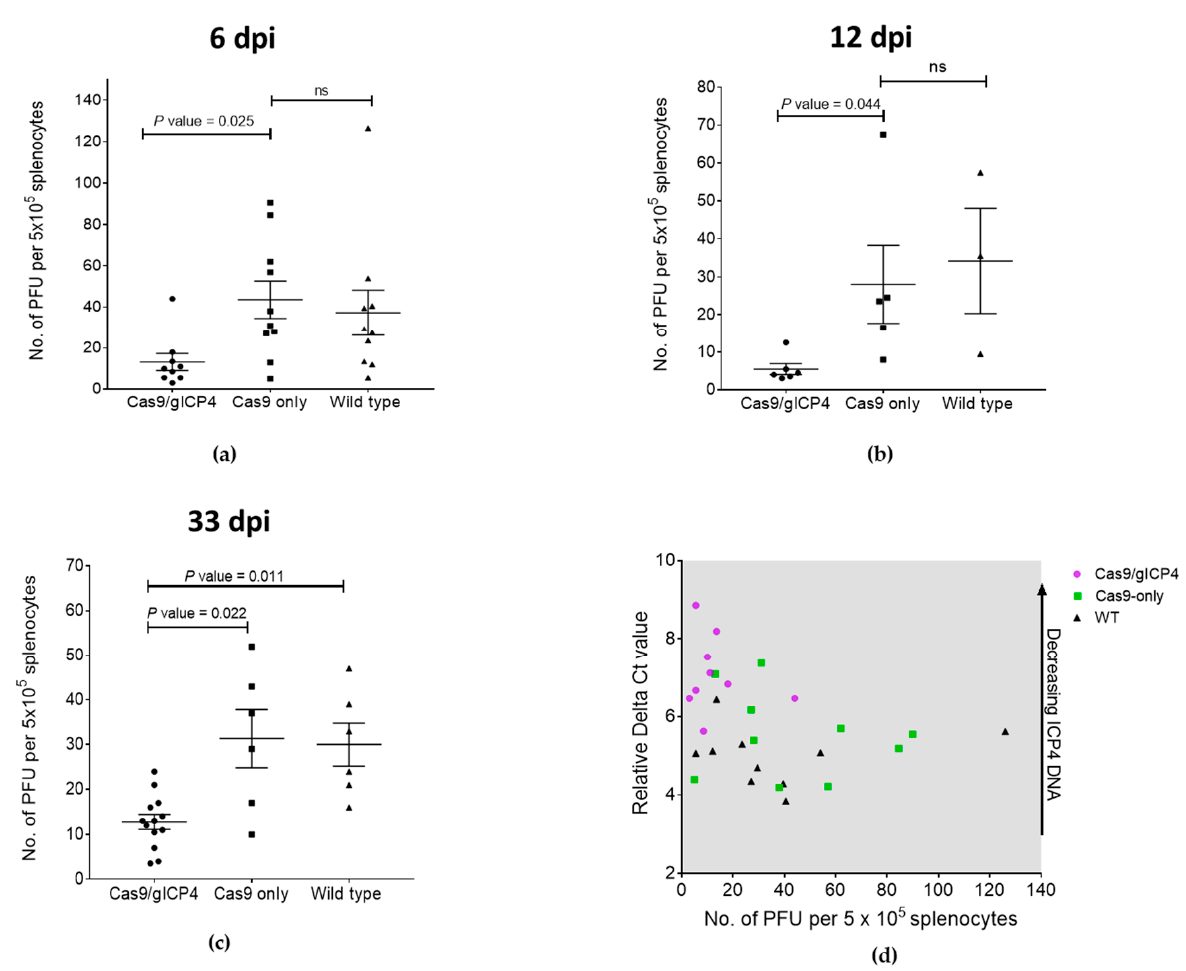
Figure 5. Inhibition of MDV in transgenic chickens expressing Cas9/gICP4. Transgenic chickens expressing Cas9/gICP4, Cas9 only or WT chickens were intraabdominally inoculated with MDV Woodland strain (p19). Spleens were harvested at ( a ) 6 and ( b ) 12 days post-infection (dpi) in experiment 1 and at ( c ) 33 dpi in experiment 2 for MDV isolation. Virus isolation assays were performed on splenocytes isolated from individual spleens by inoculating CEF with 5 × 10 5 splenocytes/well in duplicate wells. PFU were counted at 5 dpi. The viral titers were shown as number of PFU per 5 × 10 5 splenocytes. Error bars correspond to SEM. p value indicates the significance between two groups. ns denotes not significant. ( d ) qPCR-based verification of ICP4 DNA levels on 6-dpi experimental group chickens. y -axis: Delta Ct value; x -axis: PFU per 5 × 10 5 splenocytes. Black dots: WT; green dots: Cas9-only; purple dots: Cas9/gICP4.